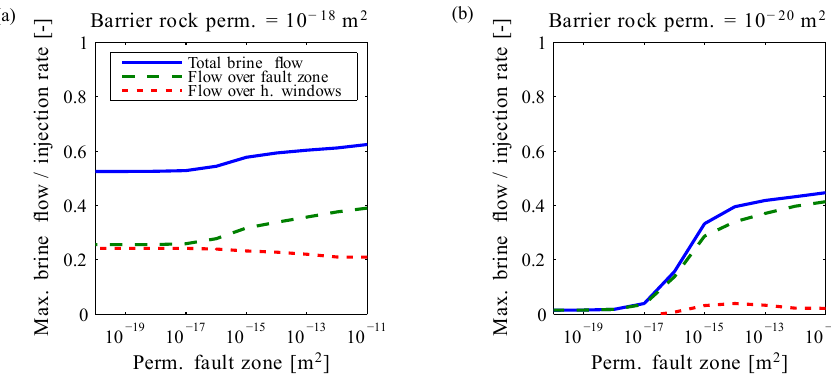
Figure 13. Scenario study 4: variable fault-zone transmissivity. Maximum brine flow into the shallow aquifers is reached after 50 years of injection (normalized by the injection rate) over the fault-zone permeability. Panel (a) shows the high Upper Buntsandstein barrier perme- ability, i.e., high diffuse migration through barrier; panel (b) shows the low Upper Buntsandstein barrier permeability, i.e., high focused migration through the fault